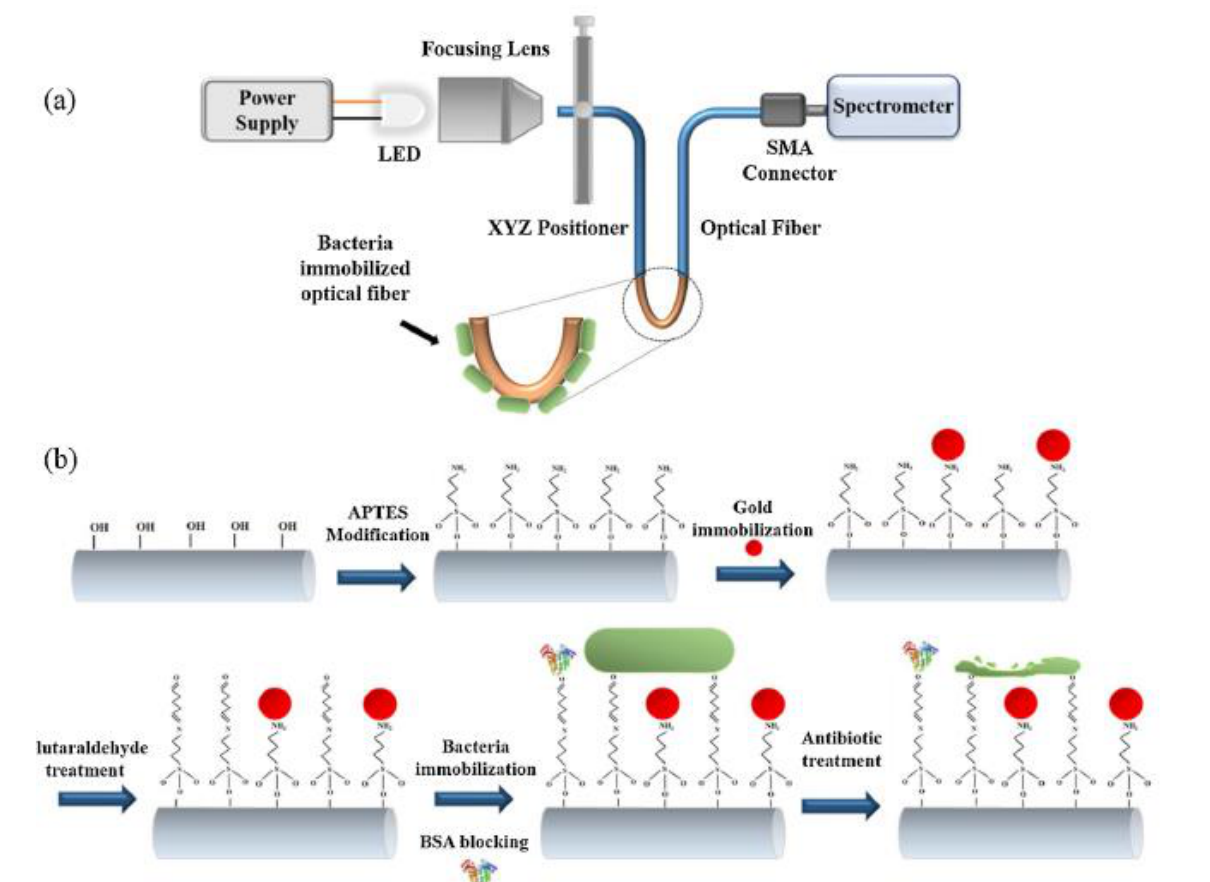
Figure 5. Schematic of an optical and sensing detection assay for the third generation of antibiotics through bacterial cells, ( a ) Optical detection assembly ( b ) The biosensing mechanism of antibiotics with bacterial cells [146] . Reprinted with permission from Elsevier.